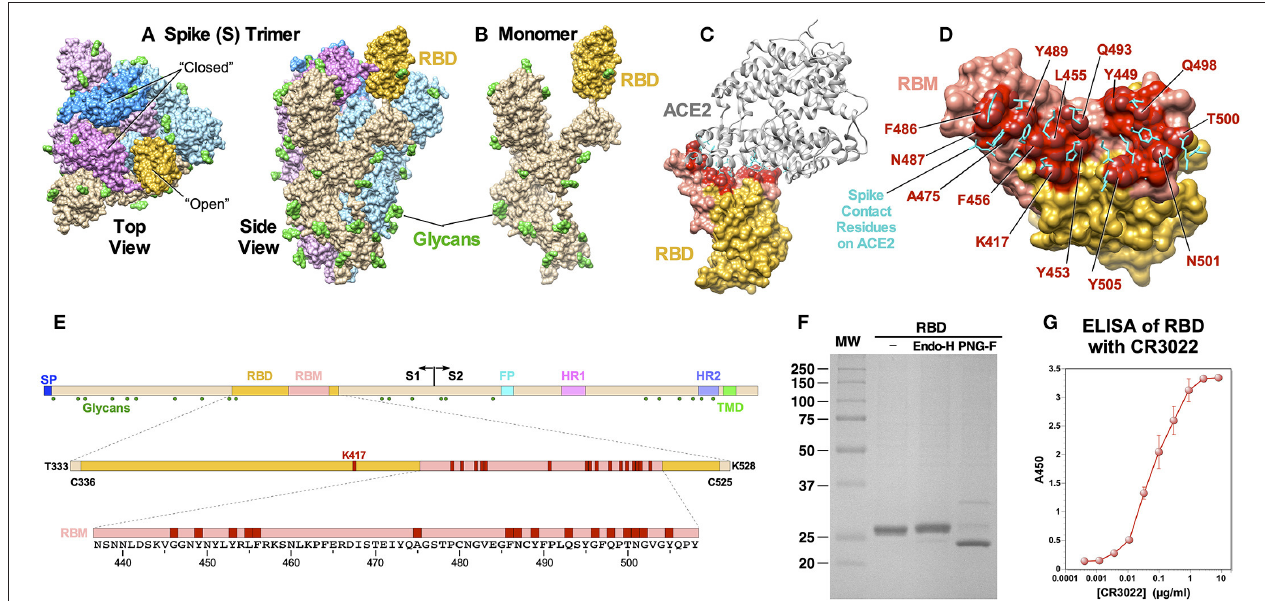
FIGURE 1 | Structural features of SARS-CoV-2S protein and RBD immunogen. (A) A cryo-EM structure of a trimer (PDB: 6VSB). Top and side views are shown, and the “open” and “closed” conformational states of the RBD are indicated. Three monomers are shown in different colors with the RBD portions highlighted in darker shades. Glycans (N-acetylglucosamine) are shown in green. (B) A monomeric S protein in an “open” state. (C) A cocrystal structure of the RBD with ACE2 (PDB: 6M0J). The RBM is shown in pink and the ACE2 binding residues are highlighted in red. (D) Details of amino acid residues involved in ACE2 binding. Side chains on ACE2 that bind the RBD are shown in cyan. (E) Schematic diagrams of S protein, RBD and RBM showing major functional domains and features. The RBM is shown in pink and ACE2-contact residues are shown in red. Glycosylation sites are shown as green hexagon. (F) SDS-PAGE of purified RBD and after treatment with endoglycosidase H and PNGase F. (G) ELISA showing binding of the RBD to neutralizing mAb